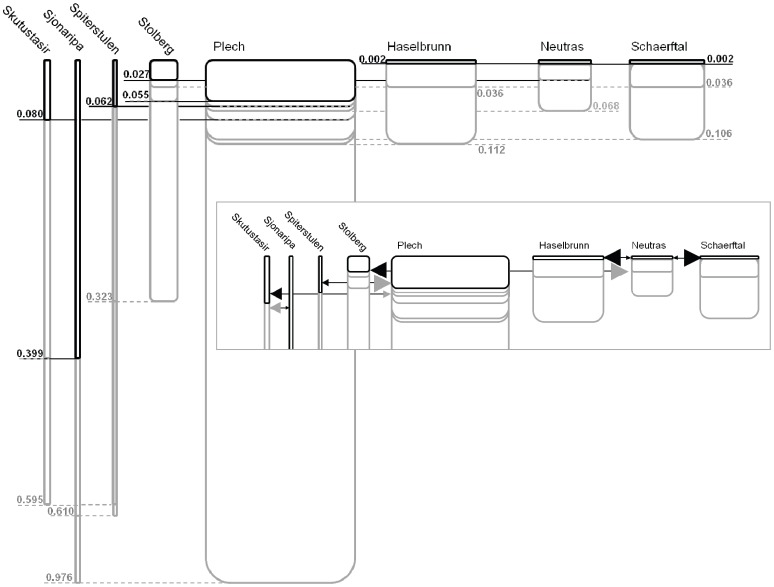
IMa results for inferred population histories.The current estimated effective population sizes are relative to the width of the box for each population. Times since divergence (in millions of years before present) are indicated by lines connecting boxes. The full black lines indicate the most recent divergence time for each population, while the dotted grey lines indicated less recent divergence times. Insert: Relative migration rates are indicated by the size of arrows. For simplicity only migration rates for the most recent divergence times for each population were included.